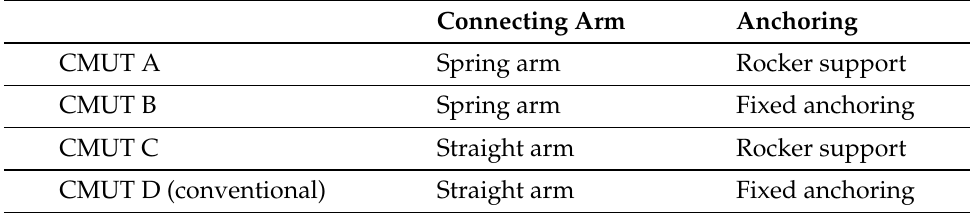
Table 1. Topology of designed